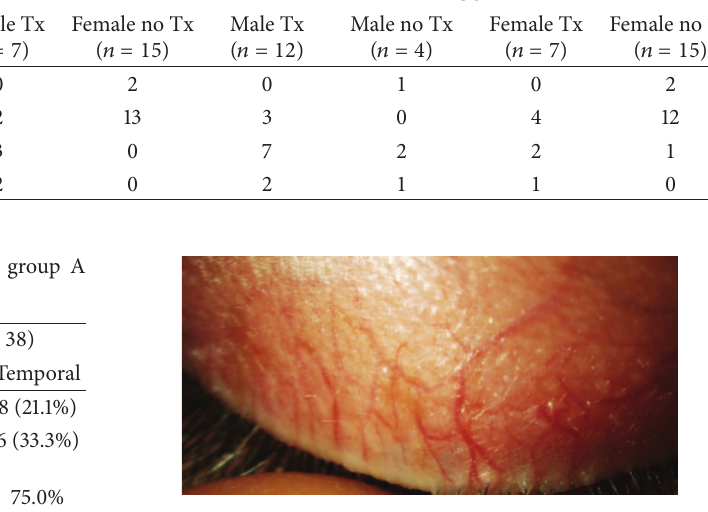
Figure 3: Moderate grade of blood vessels tortuosity.